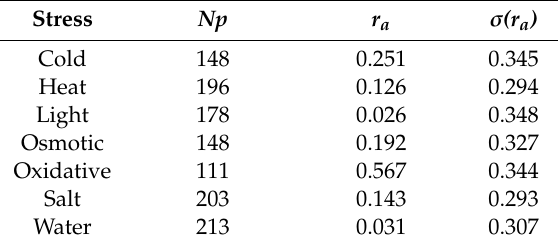
Table 6. The coe ffi cients of assortativity r a for gene ages in stress-related gene networks and estimates of their standard deviation σ ( r a ). Np -number of pairs of interacting